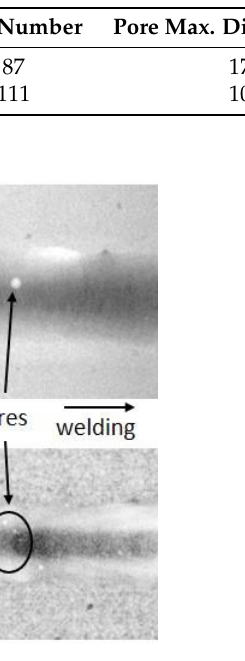
Figure 2. Radiography of the worst seam parts for the CR sample and SLM samples, respectively.